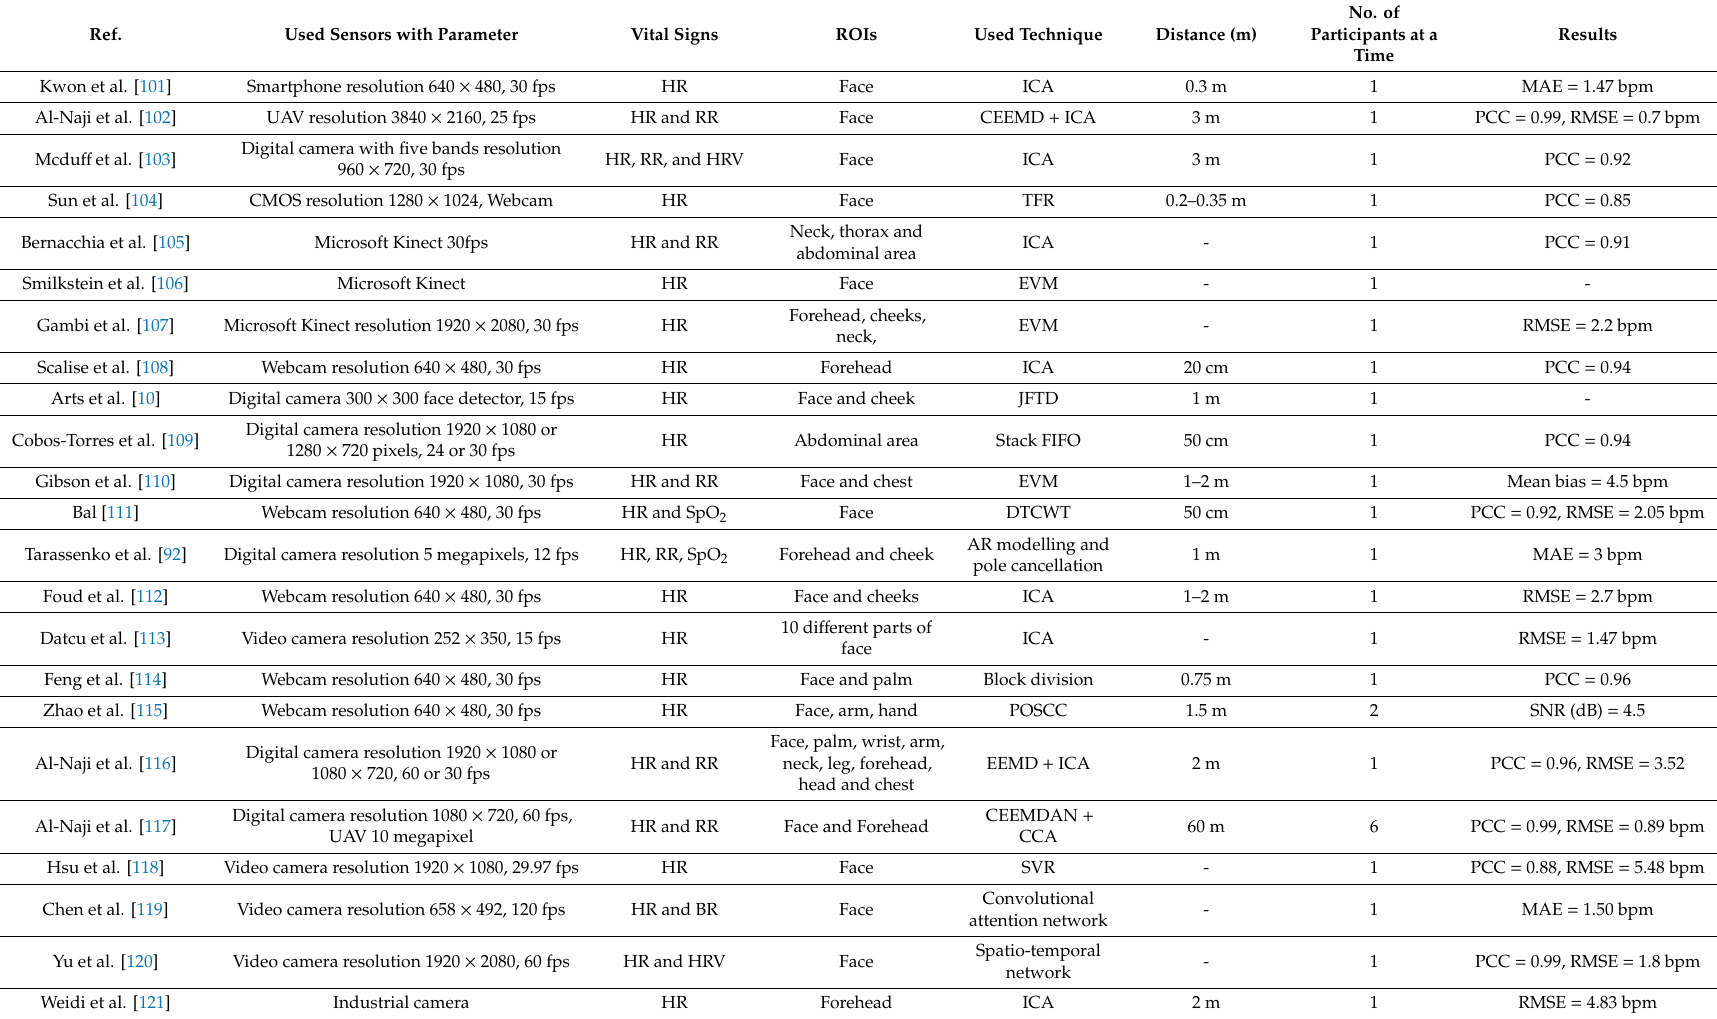
Table 5. Summary of di ff erent iPPG based